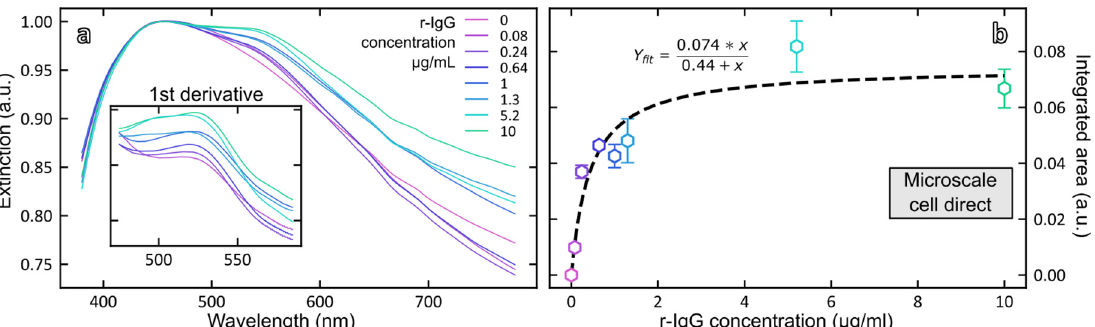
Figure 6. ( a ) Normalized and smoothed extinction spectra of immunocomplex suspensions result- ing from the addition of rabbit IgG in the range 0–10 µg/mL; ( b ) Dose–response curve plotted from the integrated area of the first order derivative spectra between 475 and 585 nm vs. rabbit IgG con- centration.